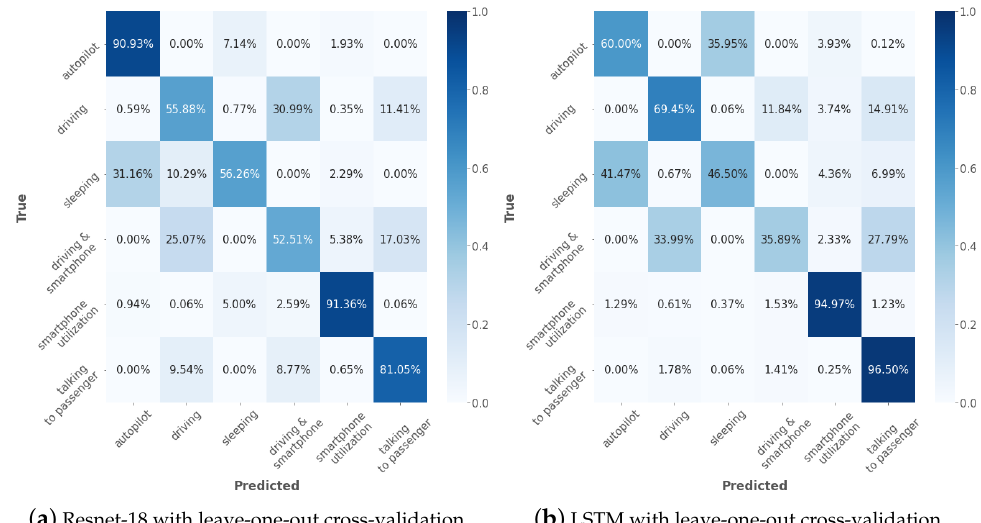
Figure 5. Confusion matrices of obtained classification results using ResNet-18 and